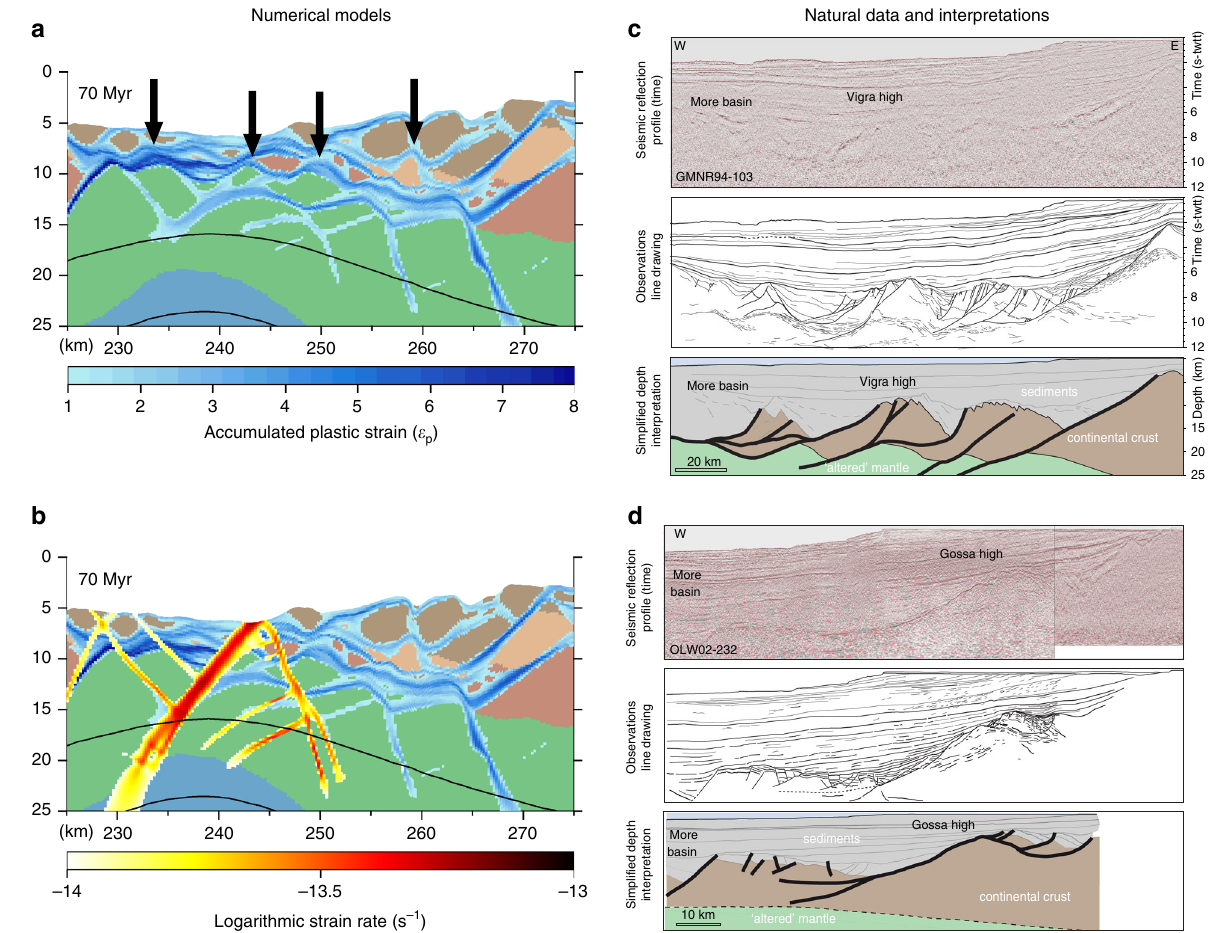
Fig. 5 Comparison of modeled and observed key structural features. a Modeled lithospheric structure and accumulated deformation (plastic strain after 70 Myr). Arrows indicate the location of core-complex structures. b Strain-rate superimposed on accumulated plastic deformation illustrates high-angle incision of active faulting on low-angle (rotated) structures. c , d Structure and interpretation, modi fi ed from previous work 9 , of distal margin structure along the Mid-Norwegian margin. This region illustrates examples of both core-complex geometry and incision of low-angle detachment faults by steeper faults penetrating into the mantle lithosphere. The GMNR94-103 and OLW02-232 seismic lines are released data at NPD 38 . The interpretations are modi fi ed from Osmundsen et al.